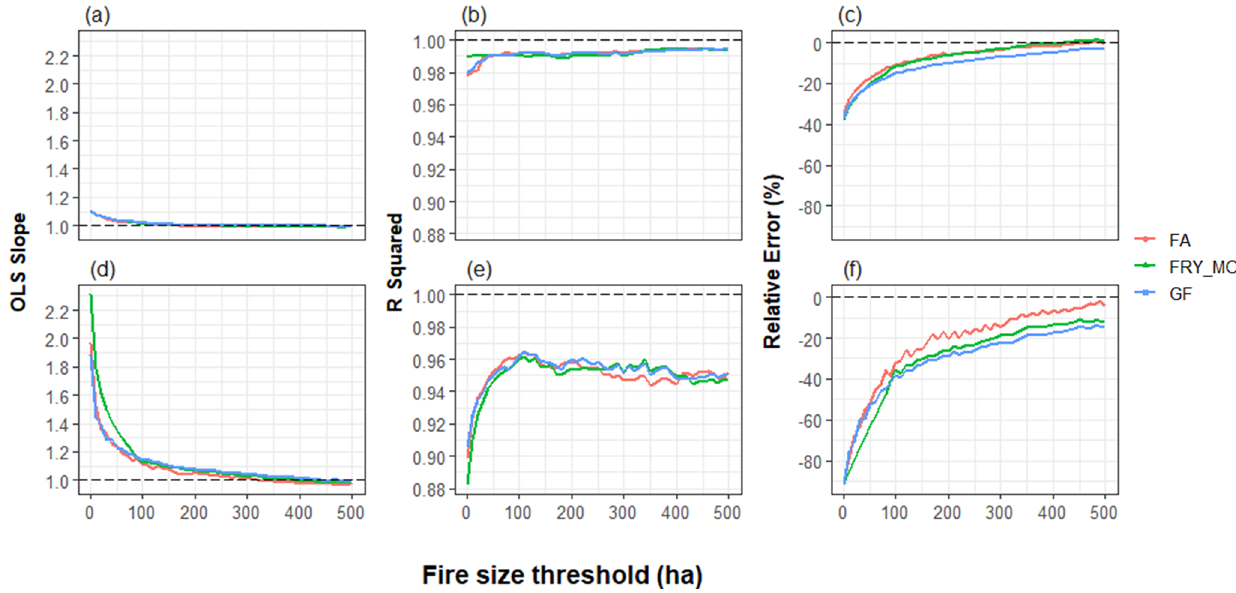
Figure 6. Evaluation of RSDs through different metrics including the slope (a, d) , R 2 correlation (b, e) , and relative error (c, f) for both burned area (a–c) and the number of fires (d–f) over a range of individual fire size thresholds (1 to 500ha). Dashed lines indicate a perfect fit between RSDs and the GBD.